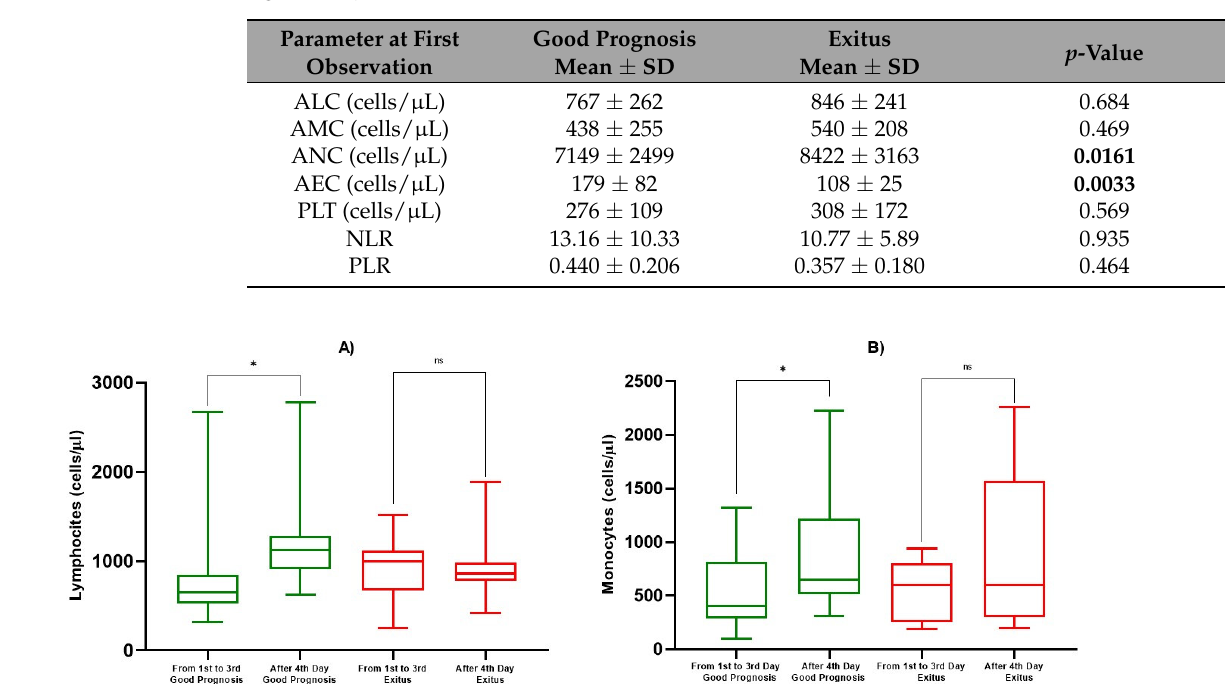
Table 2. Analysis of ALC, AMC, ANC, AMC, AEC, PLT, NLR, and PLR. Mean, deviation standard, and p -value at first observation among the Good Prognosis Group and the Exitus Group. The significant p -values are shown in bold.